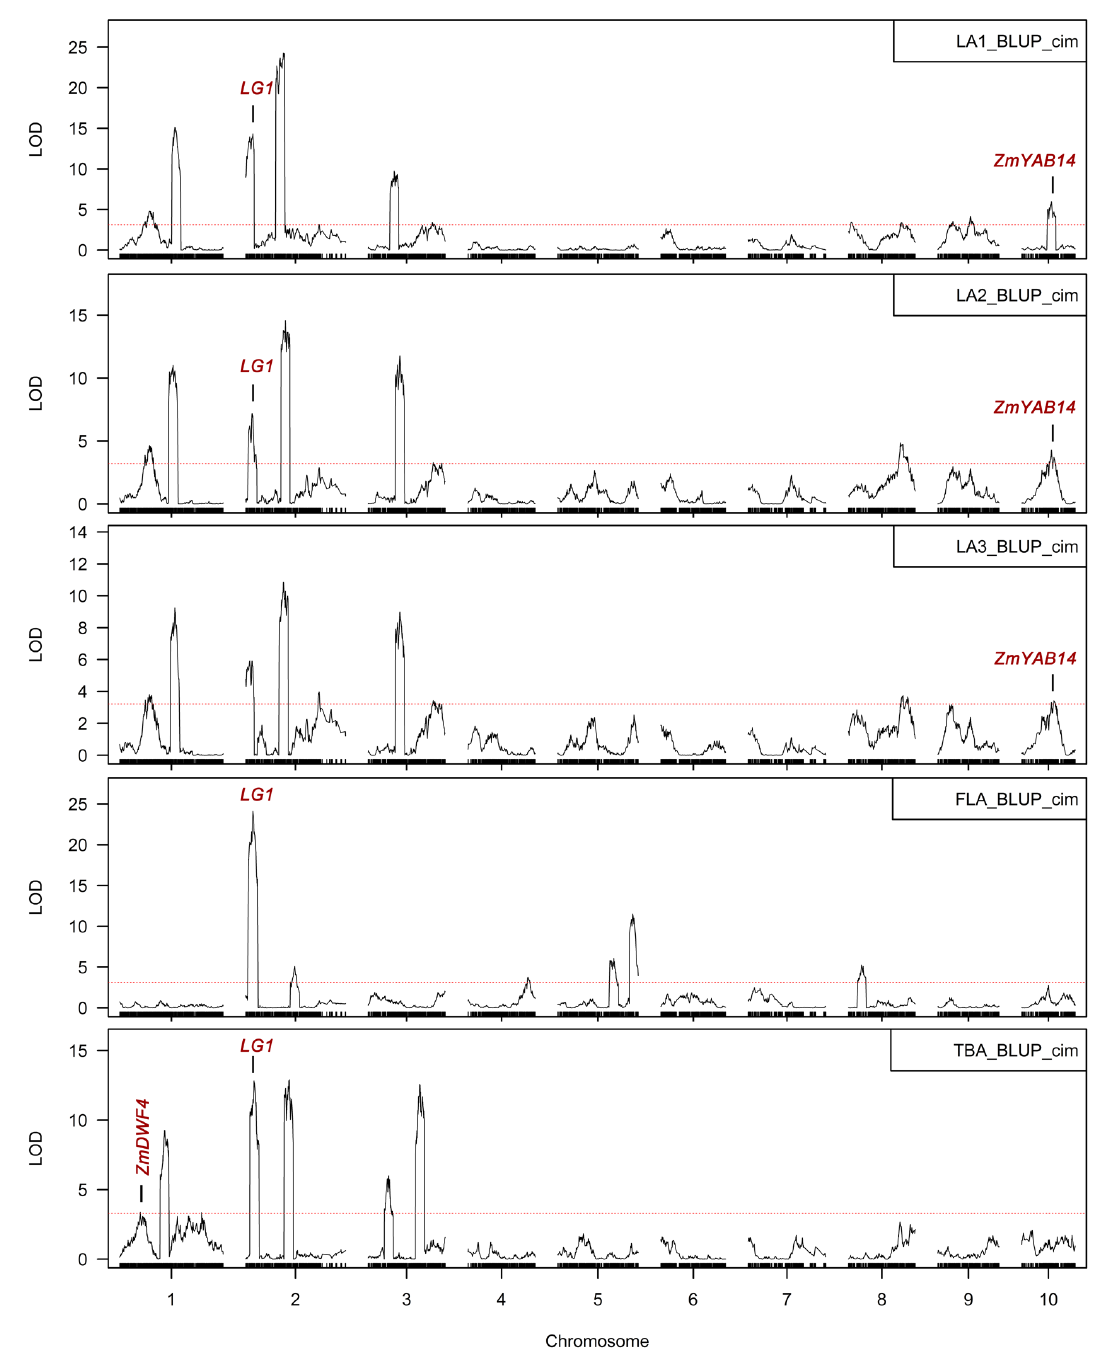
Figure 4. Results of QTL mapping of LA1, LA2, LA3, FLA, and TBA. The y -axis represents -log10 transformed p-values from t -testing; the red dotted line represents the cutoff. The positions of the candidate genes LG1 , ZmDWF4 , and ZmYAB14 are indicated by vertical bold lines. LA1_BLUP_cim, LA2_BLUP_cim, LA3_BLUP_cim, FLA_BLUP_cim and TBA_BLUP_cim represents the QTL mapping that was conducted with the BLUP values calculated for LA1, LA2, LA3, FLA, and TBA across different environments separately and the composite interval mapping was used mapping each